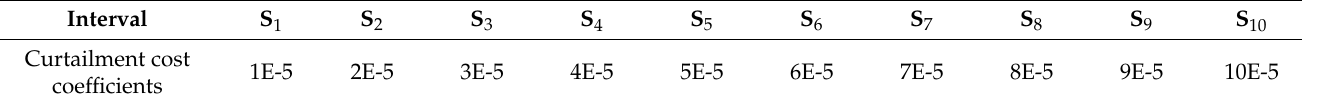
Table 2. Slope rate of each PV curtailment interval.